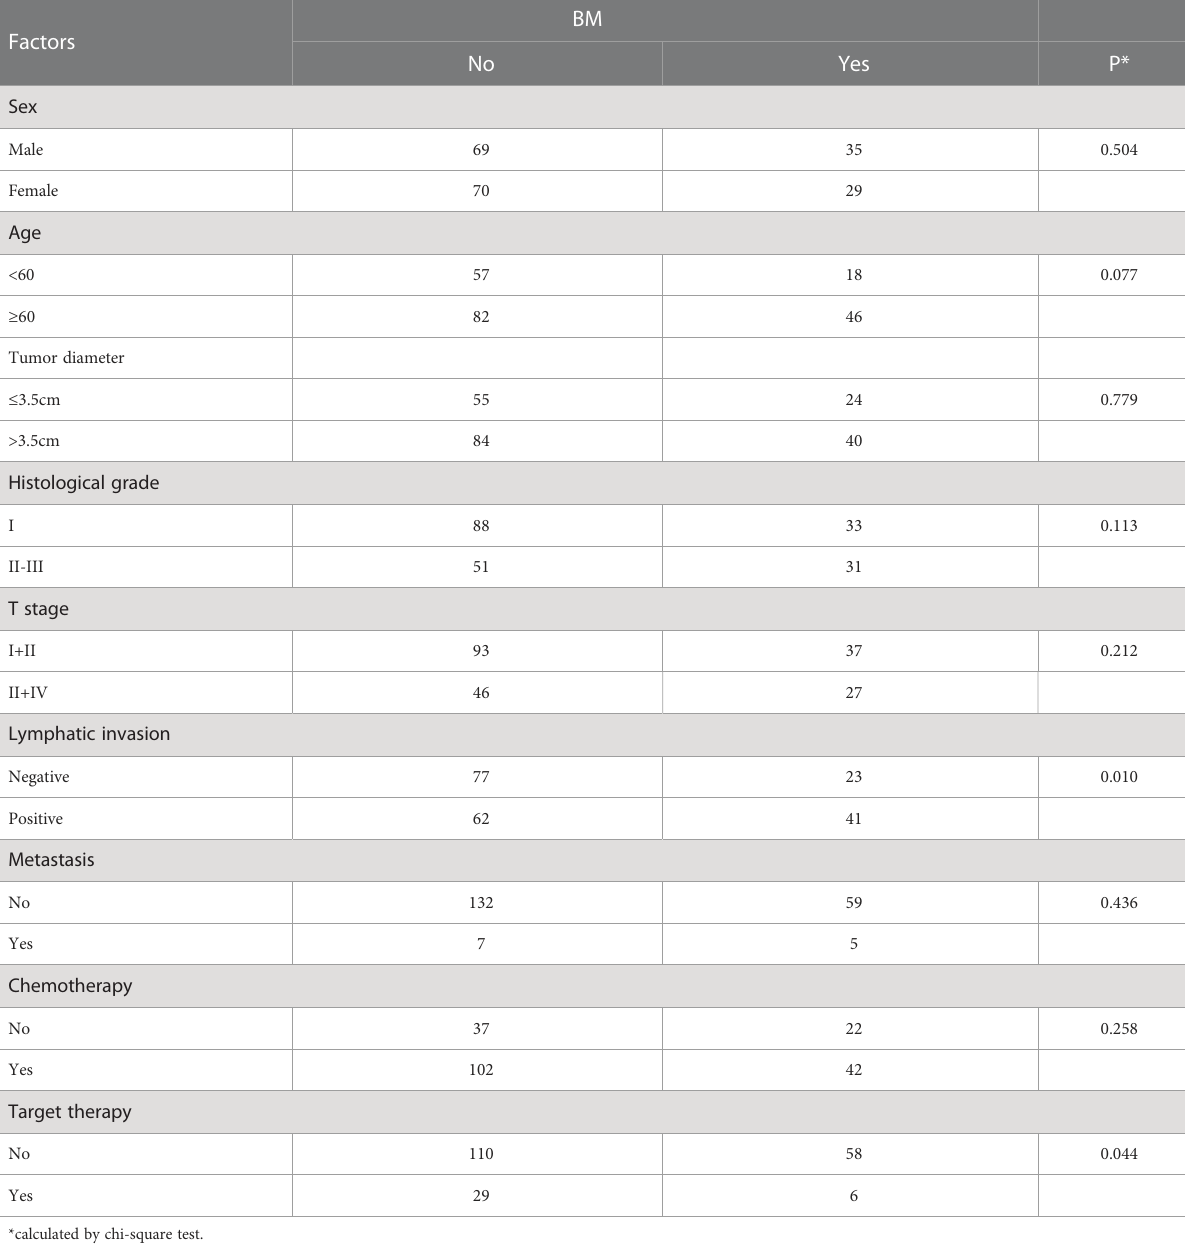
TABLE 3 The correlation between BM and clinicopathological factors in NSCLC.